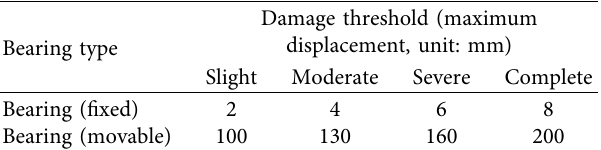
Table 8: Damage threshold of spherical bearings. Bearing